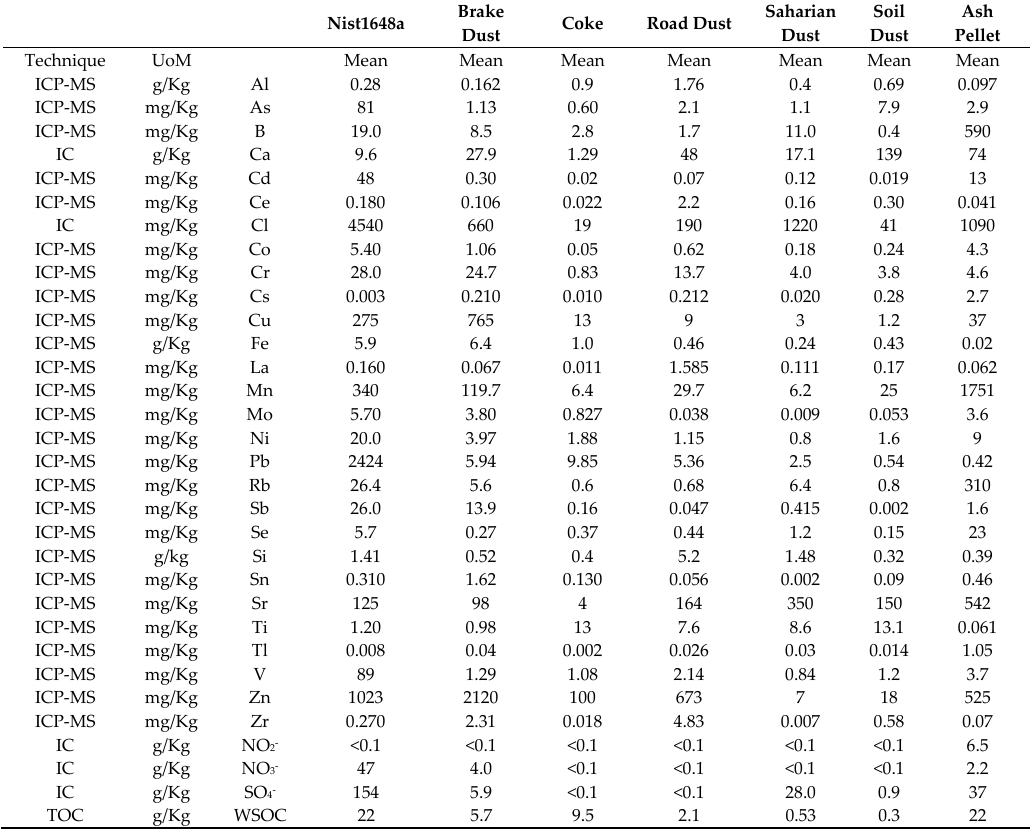
Table 1. * Chemical composition of the dust samples relative to the soluble